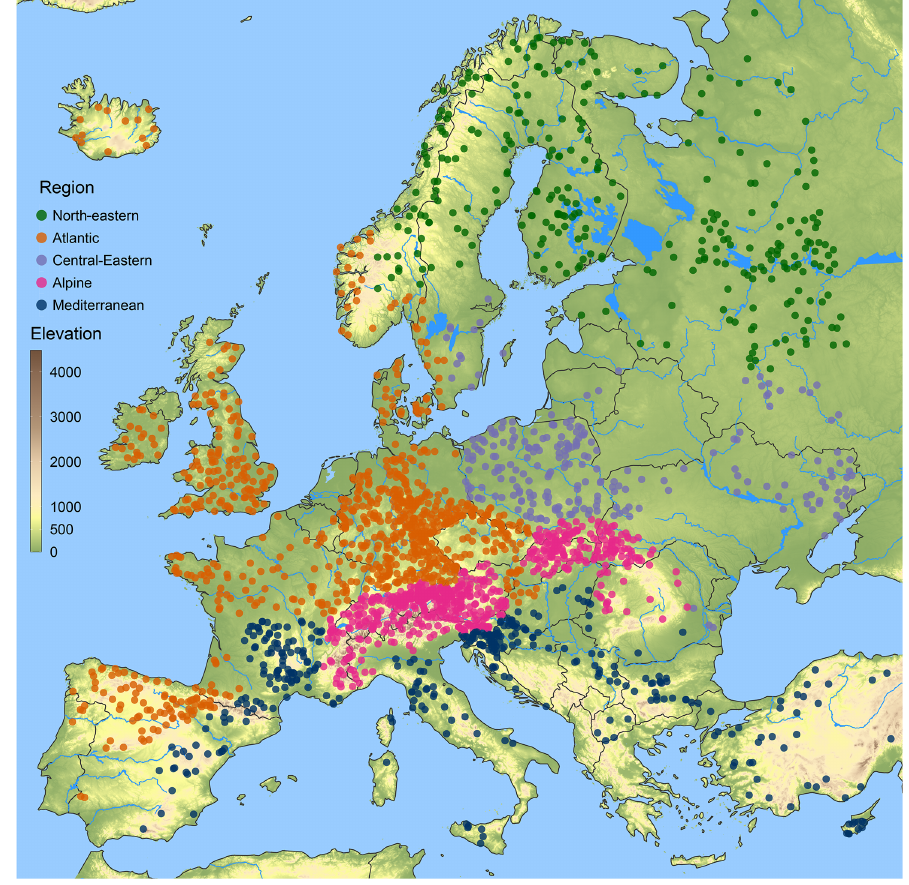
Figure 1. Location of the 2370 hydrometric stations analysed. Colours of dots indicate five hydro-climatic regions (north-eastern, Atlantic, central–eastern, Alpine, Mediterranean). Background colour is elevation